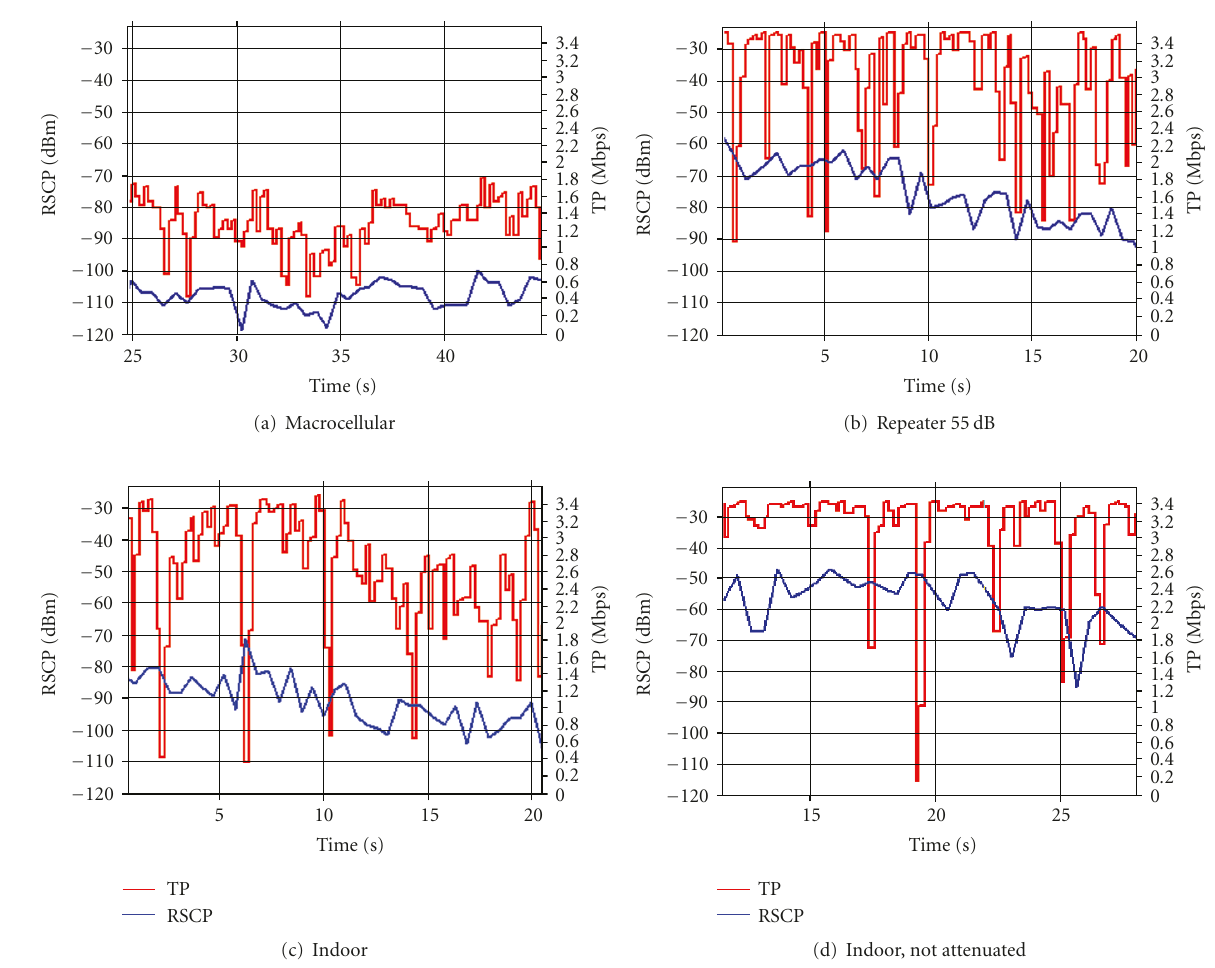
Figure 9: Examples from raw measurement data for open area environment, 1 antenna configuration. Captured on the second half of the measurement route, antenna located on the left hand